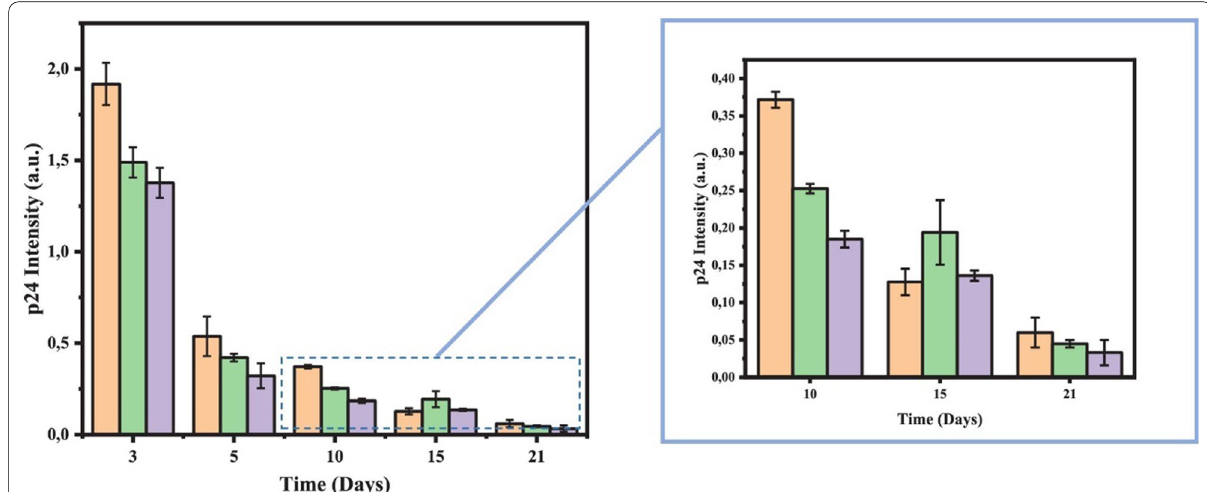
Fig. 8 p24 Intensity of HIV-1 viral post-infection to MOLT-4 cells in the presence of pure CQDs (orange bars), boronic acid modified CDs (green bars), and boronic acid modified CQDs Duviral (21 mg, purple bars). All of the data is presented as mean + Copyright © 2020, American Chemical